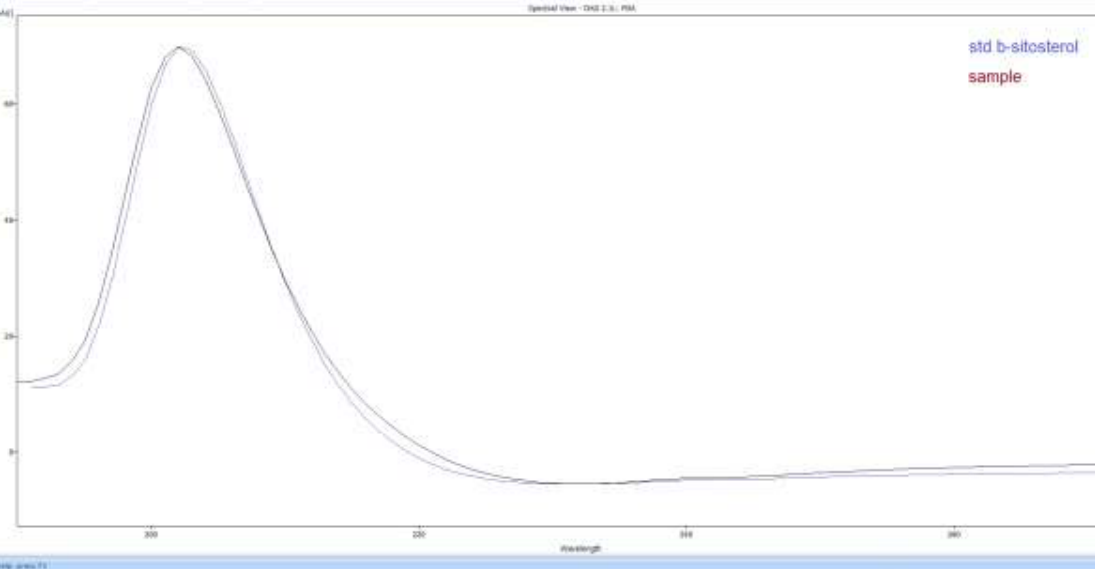
Figure 6. U.V. spectrum view using the diode array detector (DAD) for β‐sitosterol peak. STD, B-sitosterol standard absorbance(-). Sample(-),β‐sitosterol peak absorbance at λ 210 nm.